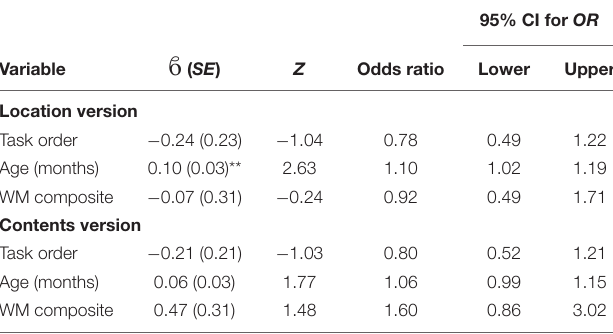
TABLE 7 | Ordinal logistic regression models for 4-option false belief